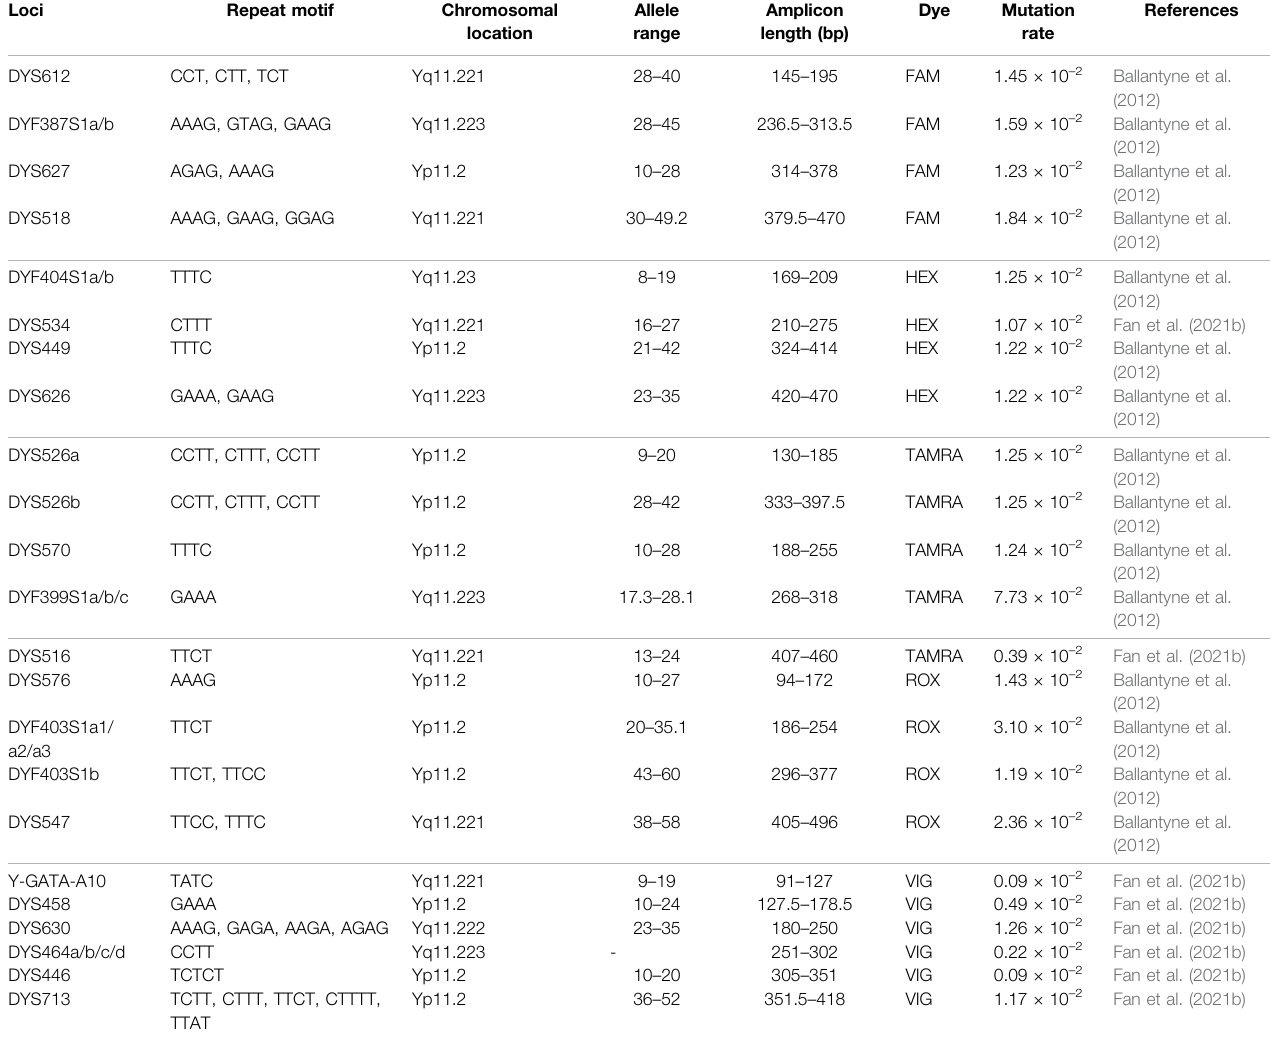
TABLE 1 | Loci information of 32 RM